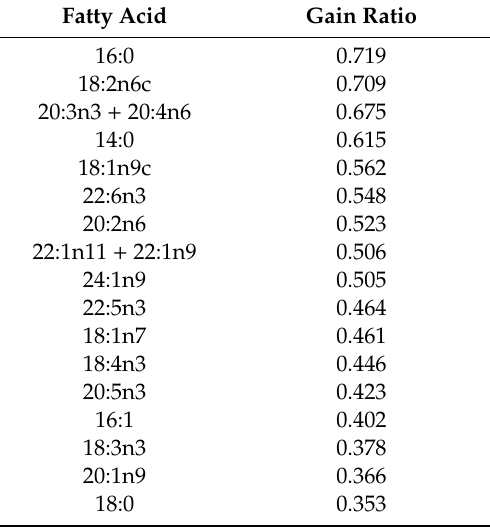
Table 3. Features sorted by applying the information gain ratio criterion. Fatty